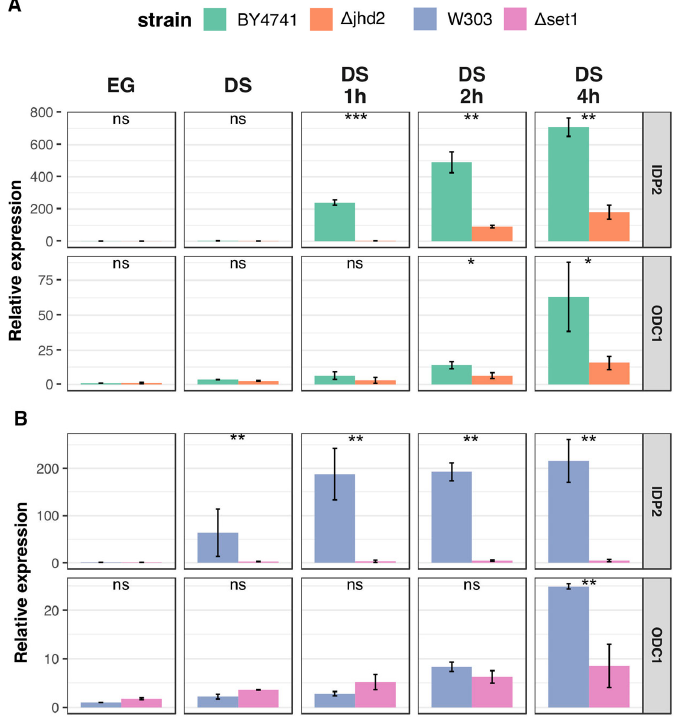
Figure 4. ( A ) Real time RT-PCR quantitation of the time course of induction of IDP2 and ODC1 in the W303 wild type and Δ SET1 strains. Data are the average of three independent experiments. Standard deviation is indicated. ns = not significant, * = p -value < 0.05; ** = p -value < 0.01; ***= p -value < 0.001 according to Student t -test. ( B ) Real time RT-PCR quantitation of the time course of induction of IDP2 and ODC1 in the BY4741 wild type and Δ JHD2 strains. Data are the average of three independent experiments. Standard deviation is indicated. * = p < 0.05; ** = p < 0.01; *** = p < 0.001 according to Student’s t -test.